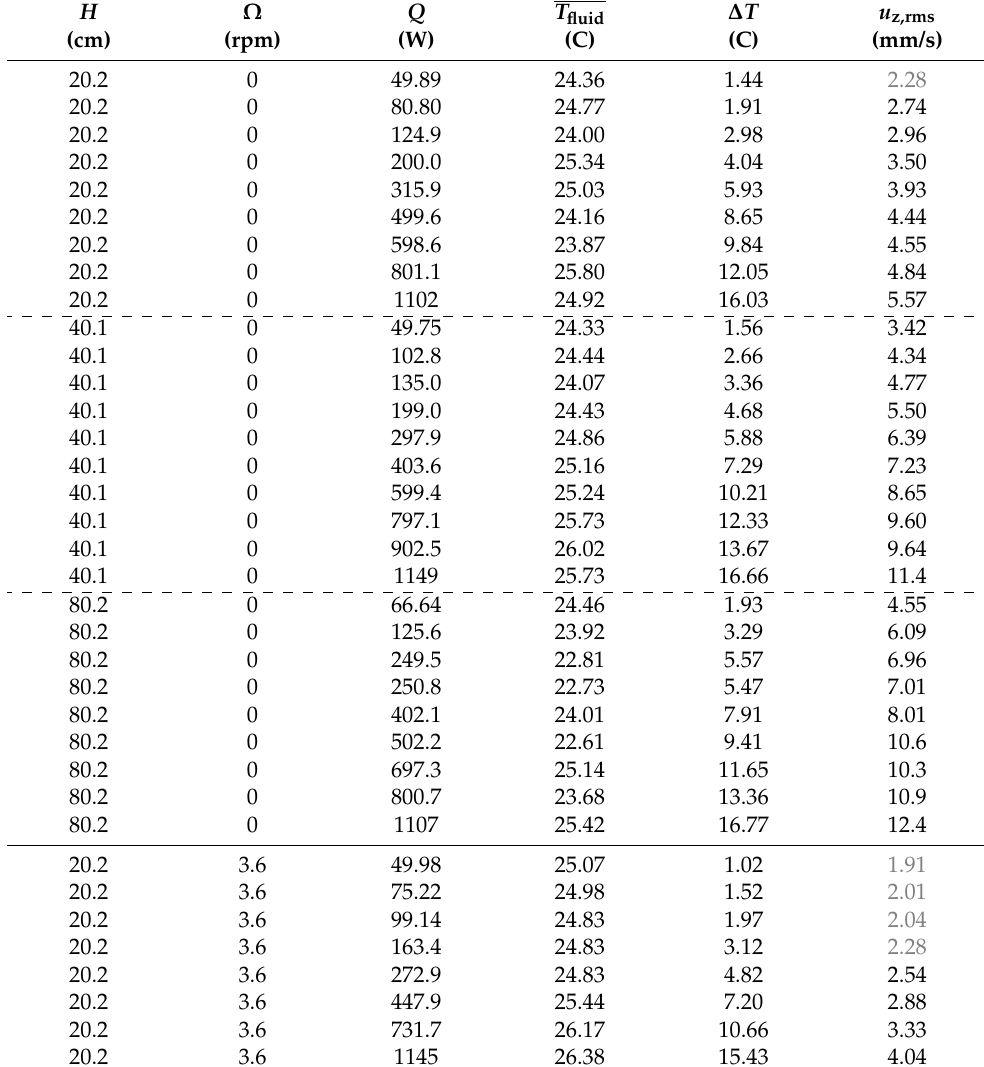
Table A1. Dimensional experimental values: H is the fluid container height (container diameter is a fixed D = 58.6 cm), Ω is the rotation rate of the container, Q is the mean input heating power, T fluid is the mean temperature of the fluid, ∆ T is the temperature difference across the fluid layer, and u z, rms is the z-rms velocity in the fluid bulk. The dashed horizontal lines separate the different aspect ratio containers used. u z, rms values that are gray indicate measurements below the determined resolution limit of 2.5 mm/s for the LDV device used in this study. A description of the errors in the parameters listed can be found in Appendix